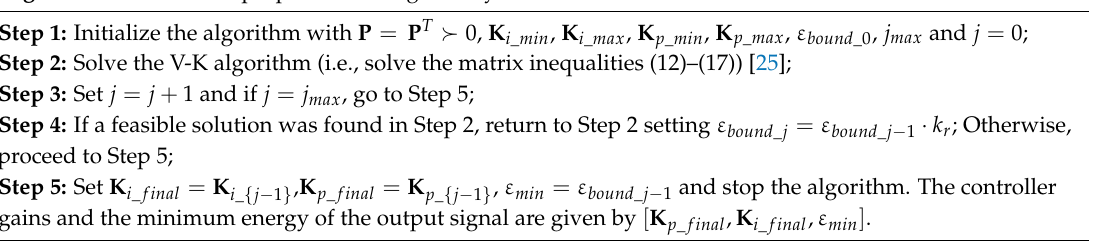
Algorithm 1: Procedure proposed to design the system